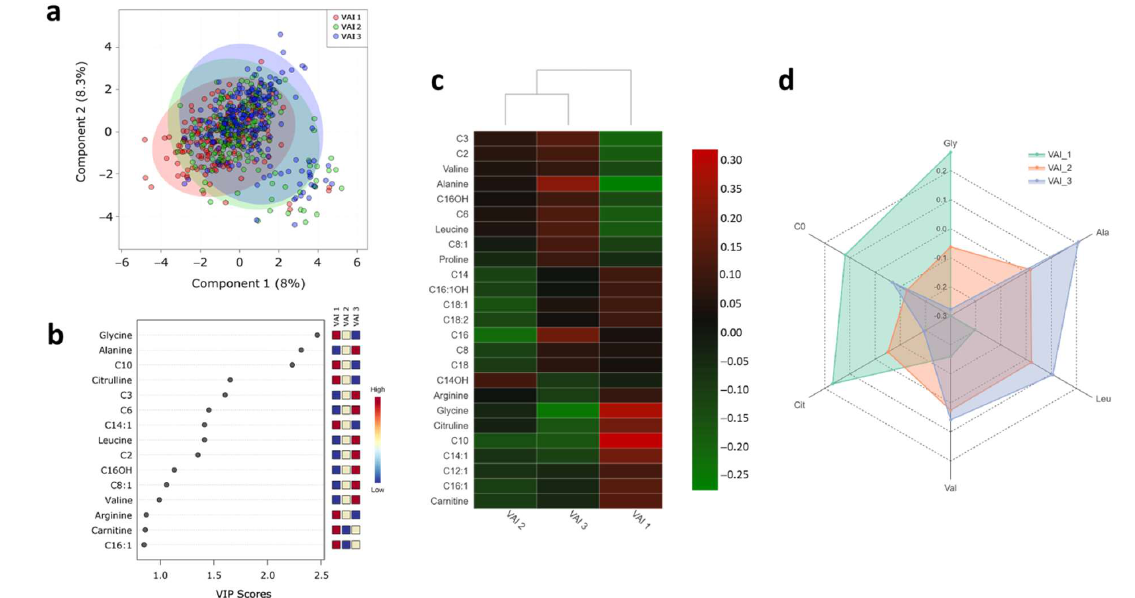
Figure 2. Serum metabolite profile according to visceral adiposity index. ( a ) PLS-DA plot shows separation between groups; VAI tertile 1 (red circles; reference group), VAI tertile 2 (green circles), and VAI tertile 3 (blue circles). The explained variances are shown in brackets (accuracy 0.43; R2 0.15; Q2 0.099: permutation p -value < 5.0 × 10 − 4 ); ( b ) VIP analysis represents the relative contribution of metabolites to the variance among groups. A high VIP score indicates a greater contribution of the metabolites to the group separation. Red and blue boxes indicate whether metabolite concentration is increased (red) or decreased (blue). ( c ) Hierarchical heatmap, red and green, indicate increase and decreased concentration, respectively. ( d ) Radar chart illustrating the abundance of amino acids and free carnitine among VAI tertiles: VAI tertile 1 (green; reference group), VAI tertile 2 (orange), and VAI tertile 3